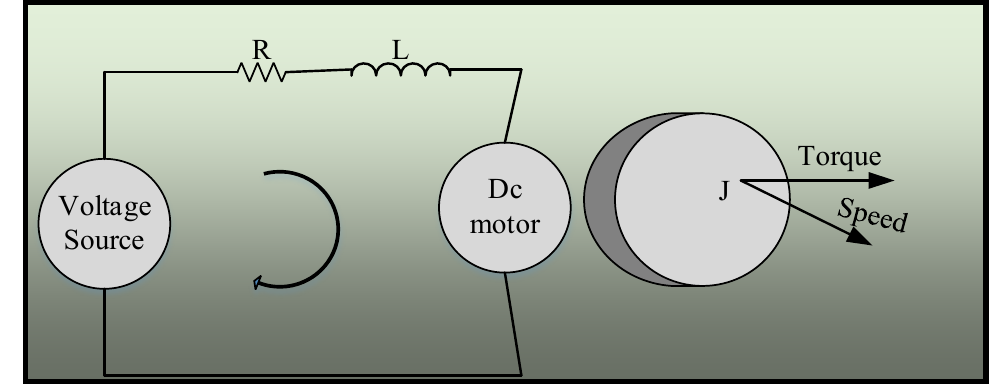
Figure 2. Model of DC motor.